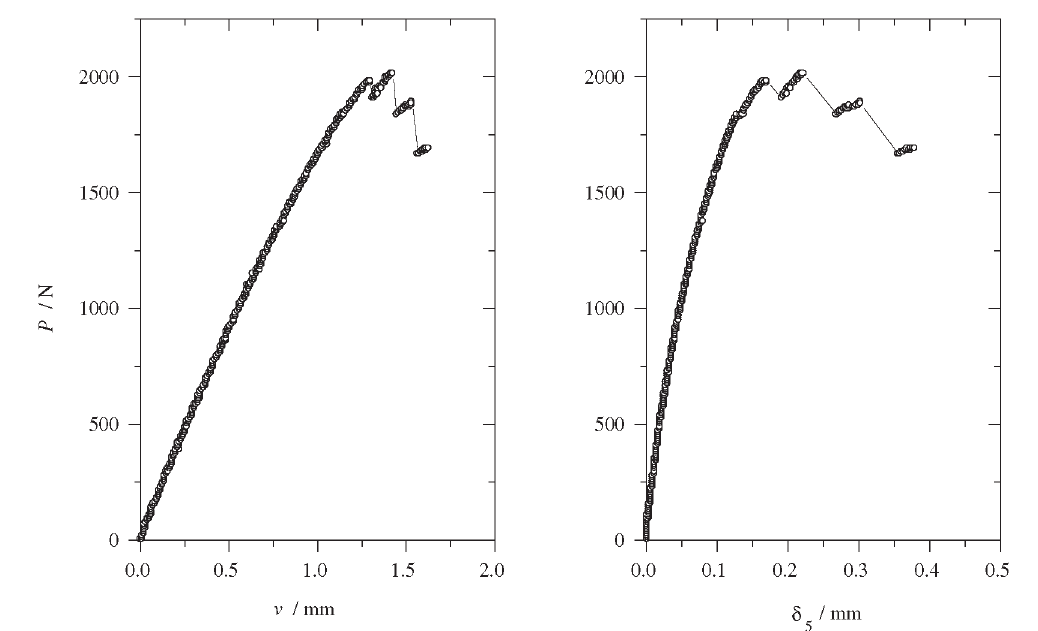
Figure 6. P vs. v and P vs. δ